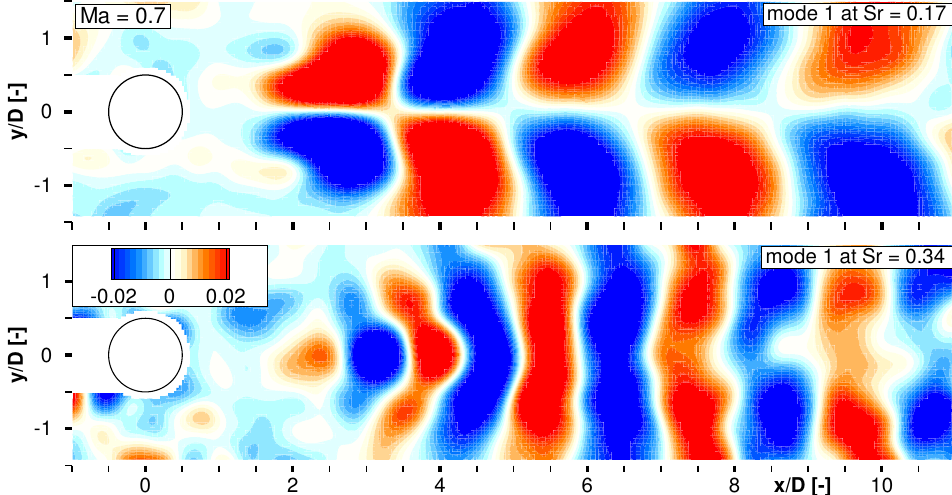
Figure 8. Reconstruction of characteristic flow patterns at Sr = 0.17 ( top ) and Sr = 0.34 ( bottom ) for Ma ∞ = 0.7.